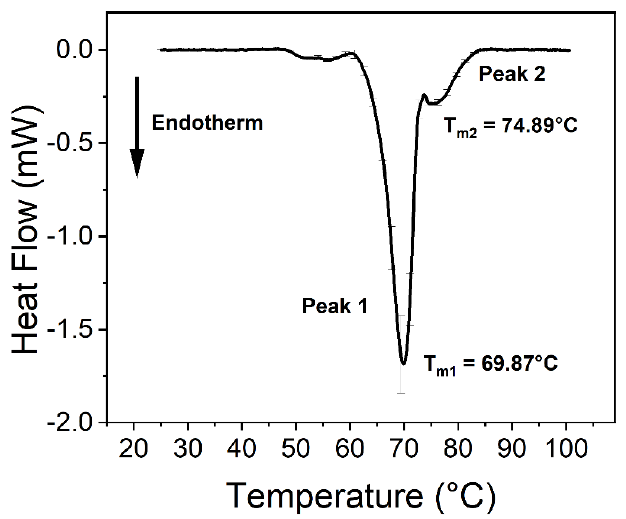
Figure 5. The thermal analysis of untreated anticoagulated whole blood samples after 2 h of incubation. The plot is an average of the same measurements repeated at different incubation temperatures (24 °C, 37 °C, and 40 °C). The DSC data represent the mean ± SD of three independent measurements ( n = 3).